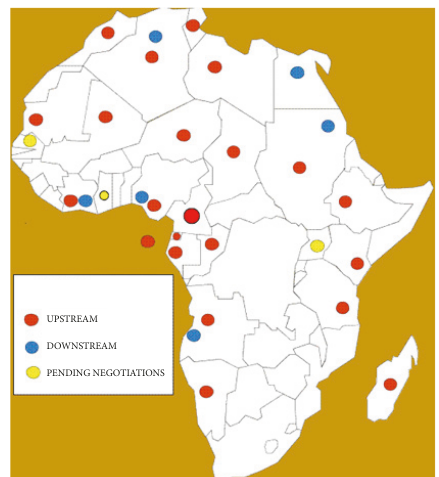
Figure3: China’sfootprintinAfrica’senergysector2009. Source:http://www.ide.go.jp/English/Data/Africa file/Manualreport/cia